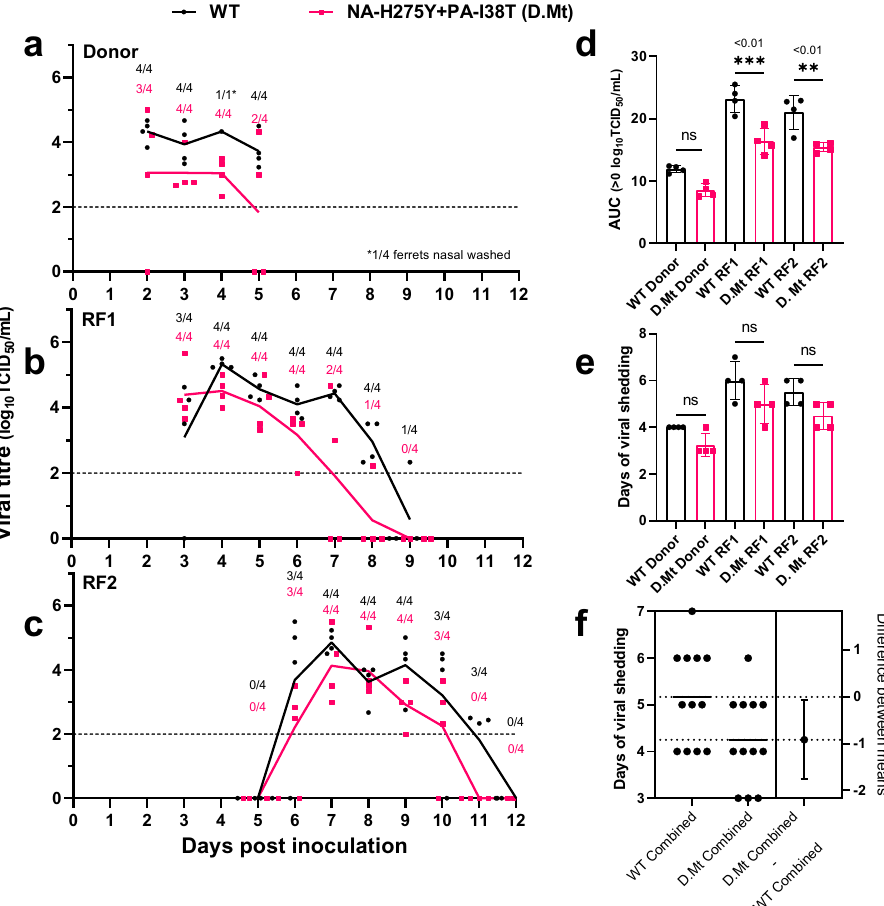
Fig. 3 Infectious viral shedding in nasal washes from ferrets infected with WT or NA-H275Y + PA-I38T clinical isolates and in ferrets infected by airborne virus exposure. Donor ferrets ( n = 4) were infected by the intranasal route with 5 log 10 TCID 50 /mL of pure WT or NA-H275Y + PA-I38T clinically isolated virus and co-housed with naïve recipient ferret 1 (RF1) separated by an airborne virus-permeable barrier at day 1 (D1) post inoculation. Infected RF1s were then co-housed with RF2 ferrets, enabling a second airborne transmission event to occur. Viral titre mean from nasal washes from donor ( a ), RF1 ( b ) and RF2 ferrets ( c ), by TCID 50 assay. Fractions above each symbol represent the number of ferrets shedding virus above LOD (dotted horizontal line), all values below LOD equal zero. No statistically signi fi cant (adjusted p < 0.05) differences was observed (Sidak ’ s Two-way ANOVA multiple comparisons). d Area under the curve analysis was performed for each individual ferret ( n = 4) and overall viral shedding was compared between WT (black) and NA-H275Y + PA-I38T (D.Mt, red). e Duration of infectious viral shedding above LOD was tallied for each ferret. f Estimation plot of the combined duration of viral shedding for all donor, RF1 and RF2 ferrets was analysed by Unpaired t -test to display a 95% con fi dence interval of the difference between the mean duration of shedding for WT and NA-H275Y + PA-I38T infected ferrets. Error bars indicate one SD. Statistically signi fi cant differences ( p < 0.05) were compared by Tukey ’ s Ordinary One-way